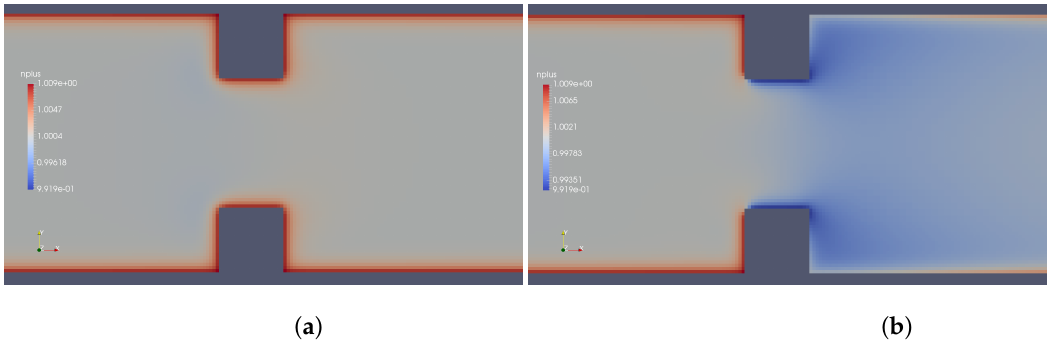
Figure 15. Ionic concentration n + . ( a ) ω ∗ = 0 and ( b ) ω ∗ = 6.0 × 10 − 3 .